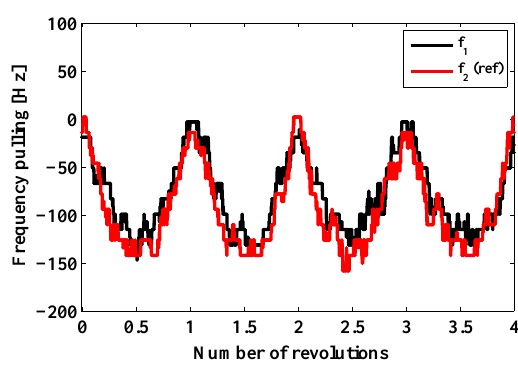
Figure 17. Measured angular frequency pulling obtained from a dual resonator temperature SAW sensor (gap: 3mm, 25 ◦ C).